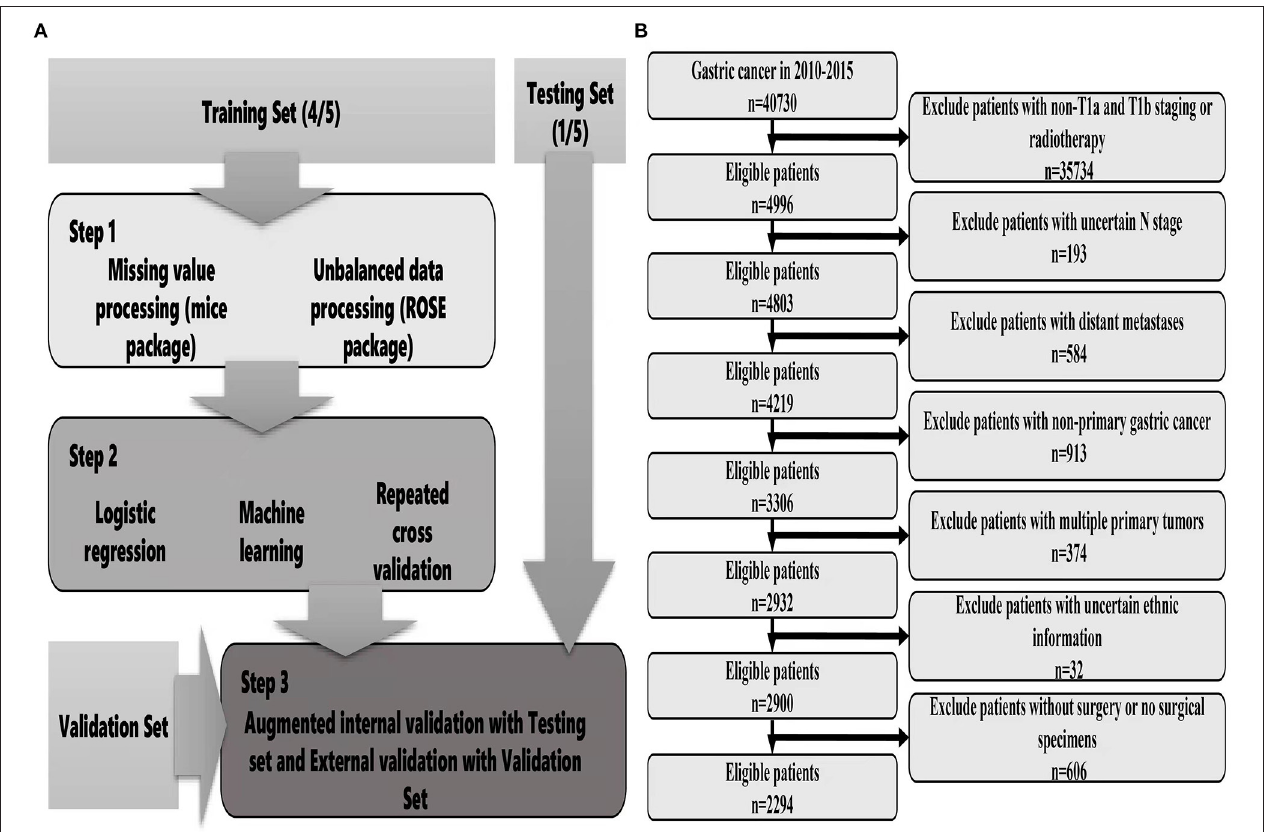
FIGURE 1 | Flow chart of data screening and statistical analysis [ (A) statistical analysis; (B) data